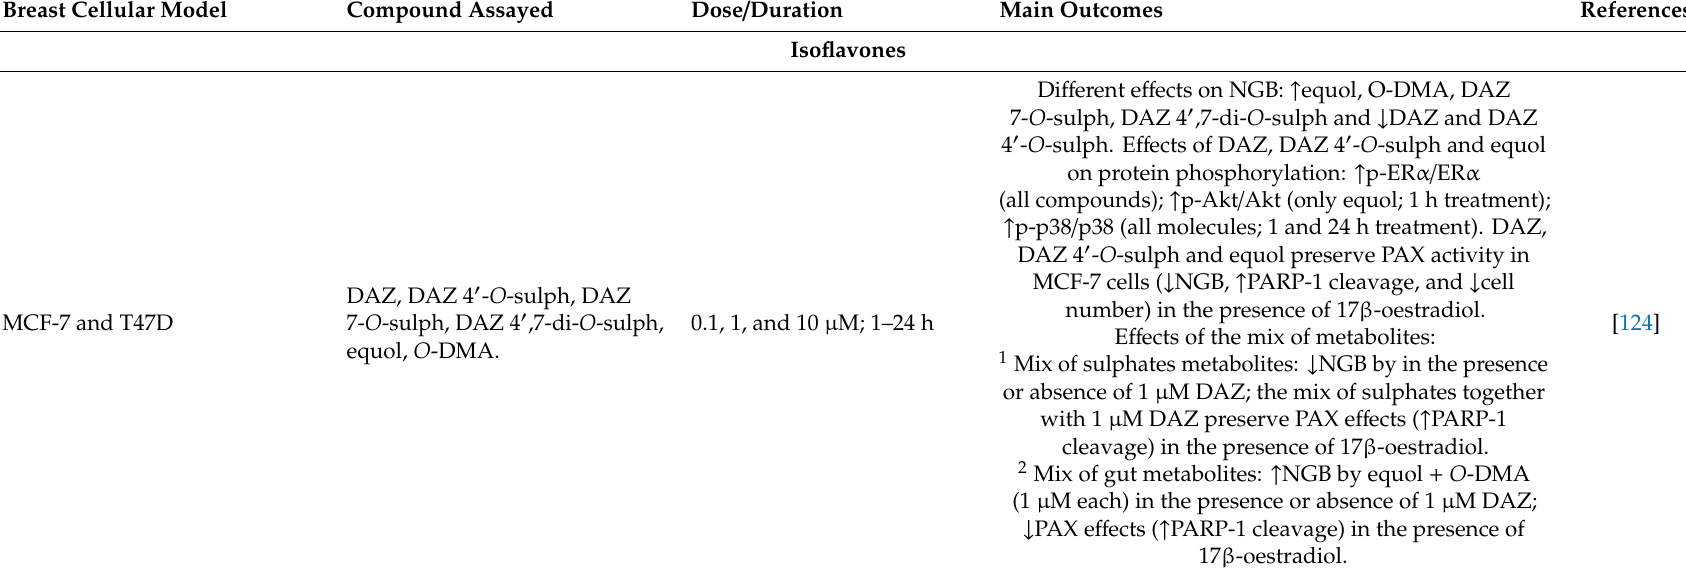
E ff ects of the mix of metabolites: 1 Mix of sulphates metabolites: ↓ NGB by in the presence or absence of 1 µ M DAZ; the mix of sulphates together with 1 µ M DAZ preserve PAX e ff ects ( ↑ PARP-1 cleavage) in the presence of 17 β -oestradiol.